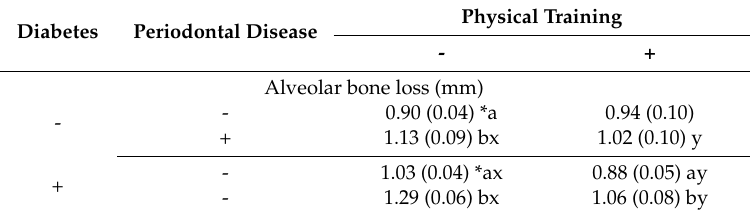
Table 4. Alveolar bone loss of type 2 diabetic rats (HFD/STZ) with ligature-induced periodontal disease submitted to eight weeks of physical training.